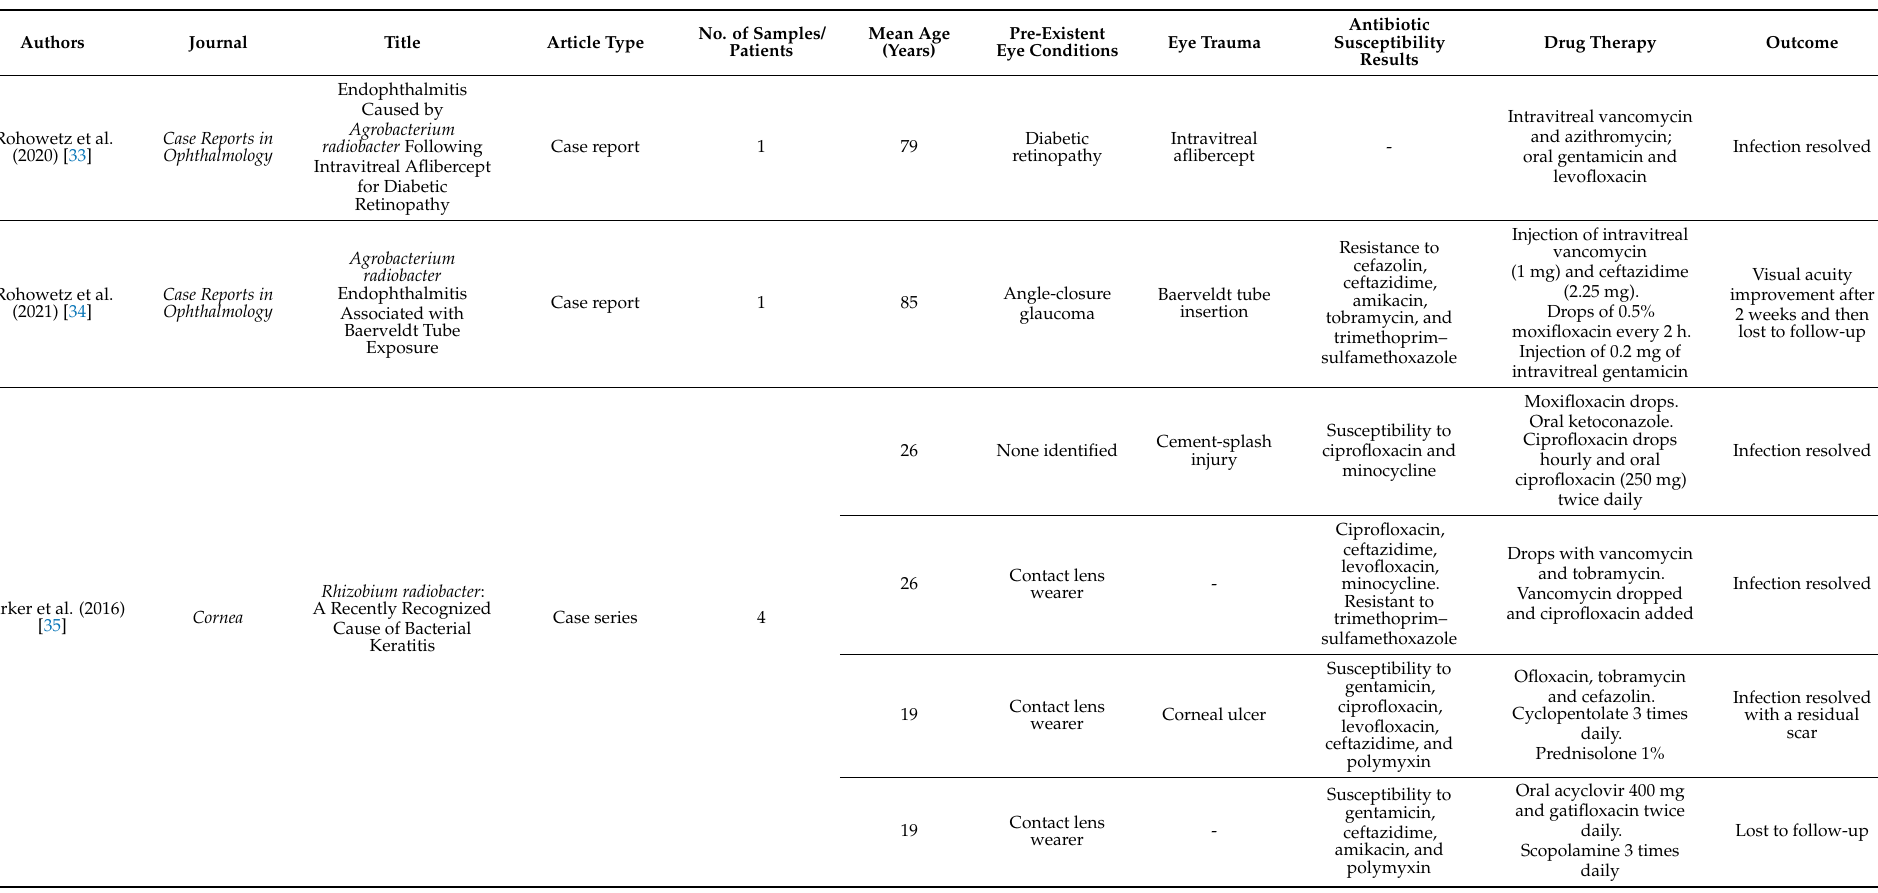
Table 2. The studies included in this